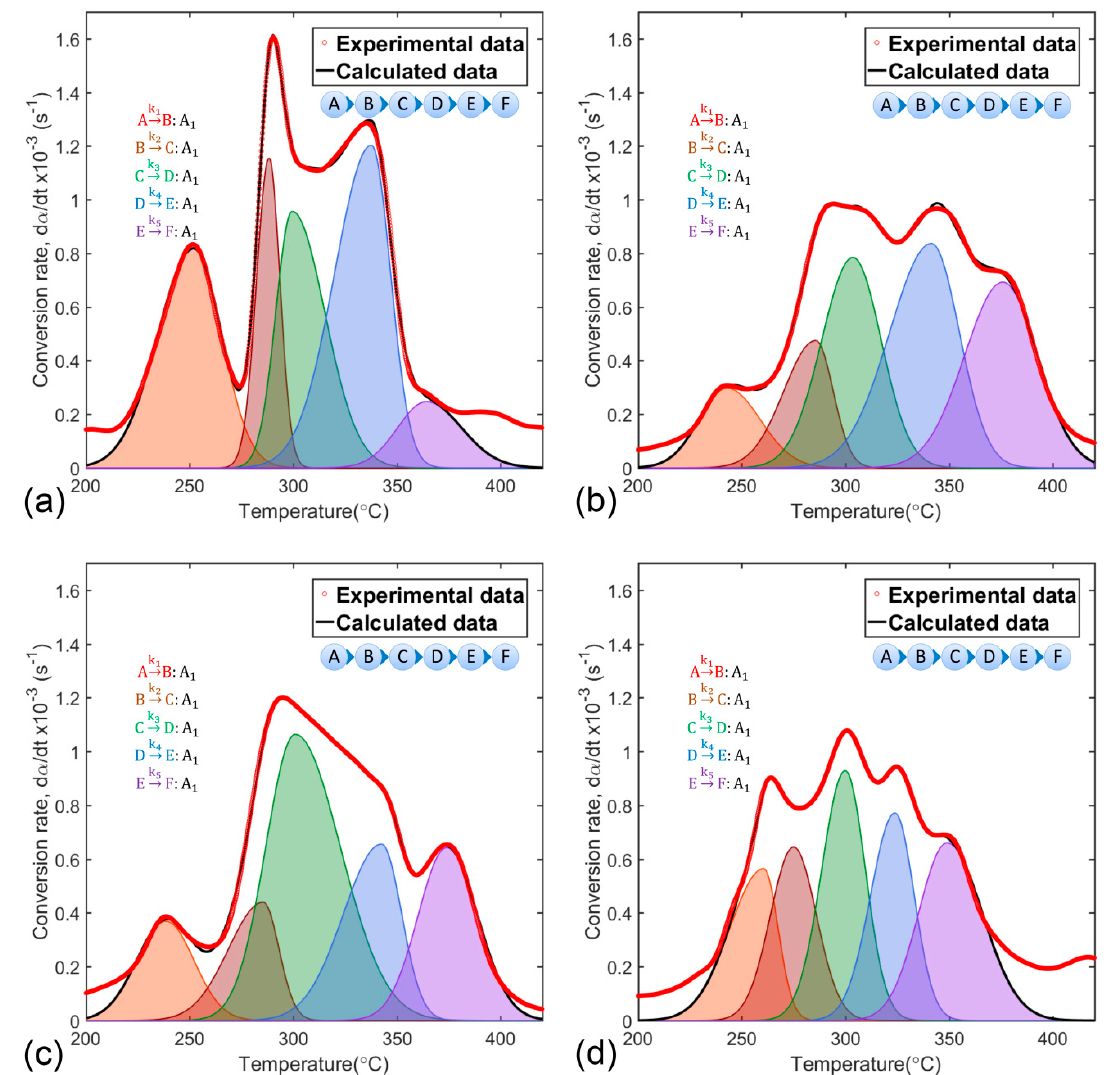
Figure 4. Experimental and calculated conversion rate curves based on a scheme of five successive reactions of polymeric matrix decomposition of the synthesis precursors ( a ) SP, ( b ) SPMg-1, ( c ) SPMg-2, and ( d ) SPMg-3.